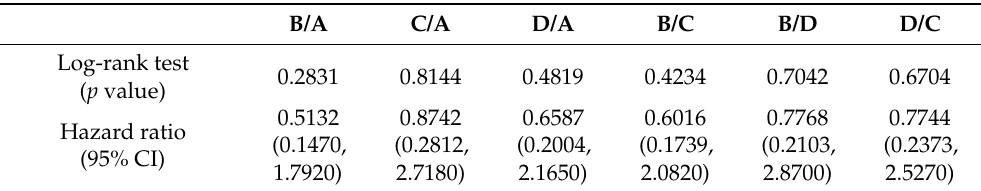
Table 3. The statistical results of survival outcomes between different meropenem treatment groups in sepsis rat